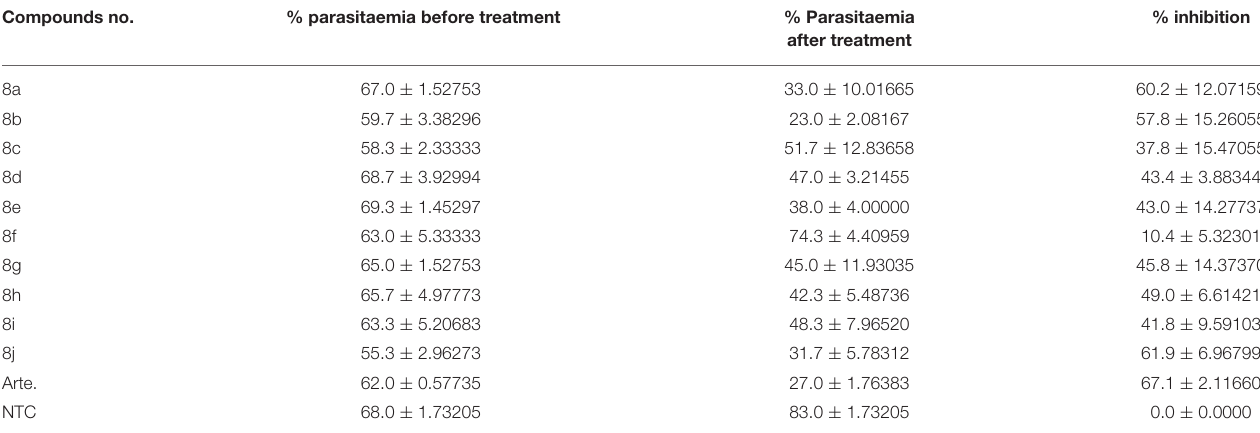
TABLE 5 | Percentage inhibition of parasite in mice. Compounds no. % parasitaemia before treatment % Parasitaemia